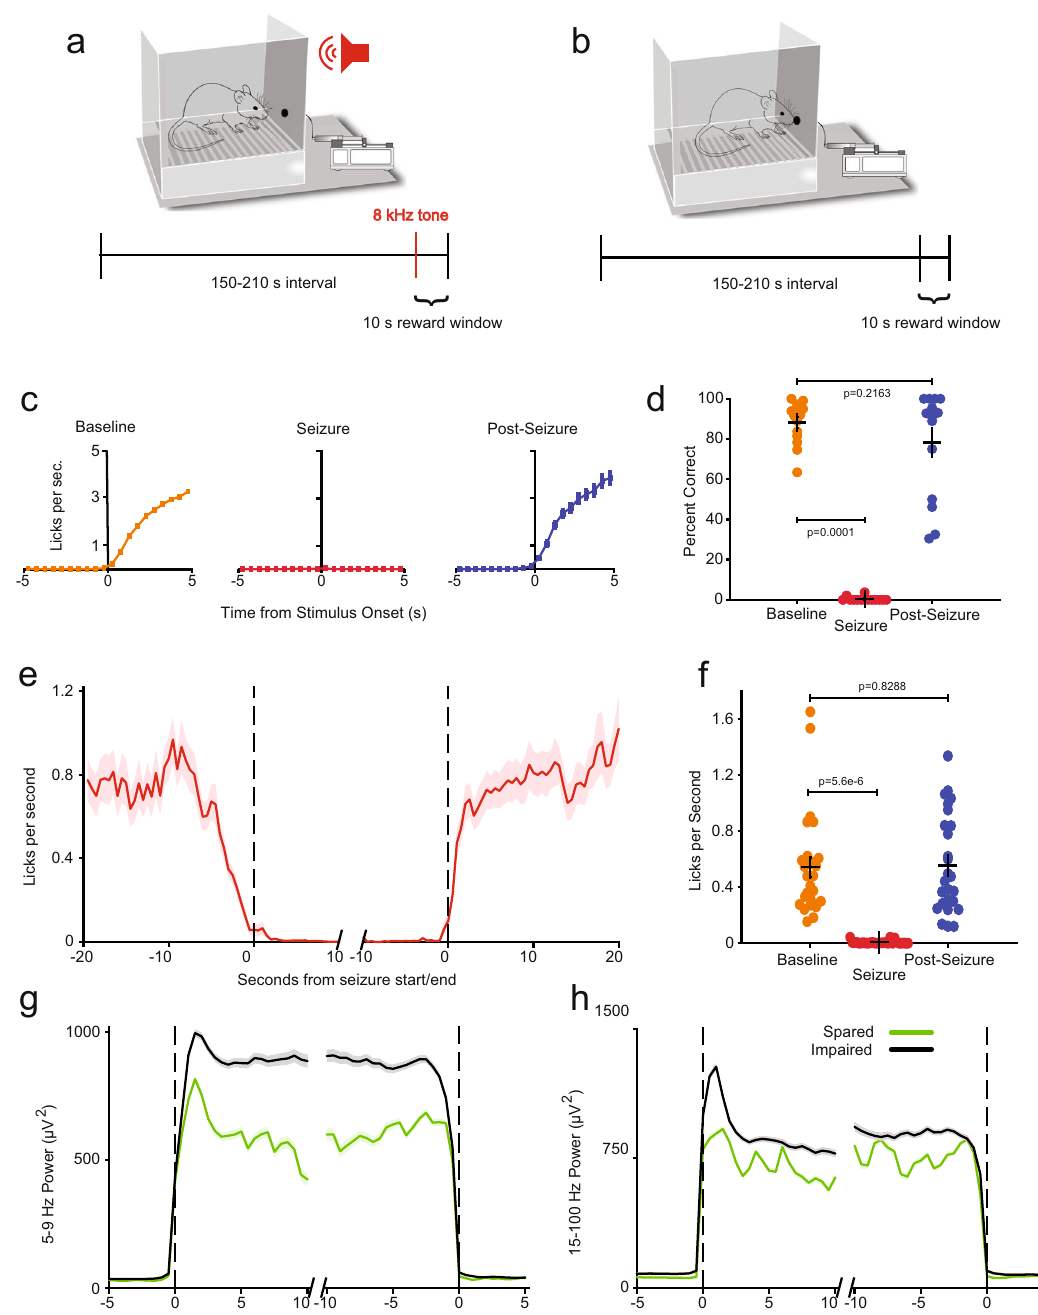
Fig. 2 | Behavioral impairment of rats in two different tasks during absence seizures. a Design of conditioned auditory response task ( n =14 animals (427 sei- zures)). b Design of continuous motivated licking paradigm ( n =27 animals (3146 seizures)). c Lick rate in 0.5s bins following conditioned auditory stimuli delivered at baseline (amber, 20s or more from the start and/or end of a seizure), during seizure (red), and in the 10s immediately post-seizure (blue). ( n =427seizures). d Percentofconditionedstimulirespondedtowithinthereward window and within the speci fi ed state for baseline, seizure, and immediate post- seizure periods for each animal showing decrease during seizure and recovery in post-seizure ( n =14 animals, colors as in c ). e Dynamics of lick rate in 0.5s bins around seizure start and end times in continuous motivated licking paradigm ( n =27animals). f Meanlickrates duringbaseline (20s ormorefrom the start and/ or end of a seizure), seizure, and immediate (up to 20s) post-seizure periods in